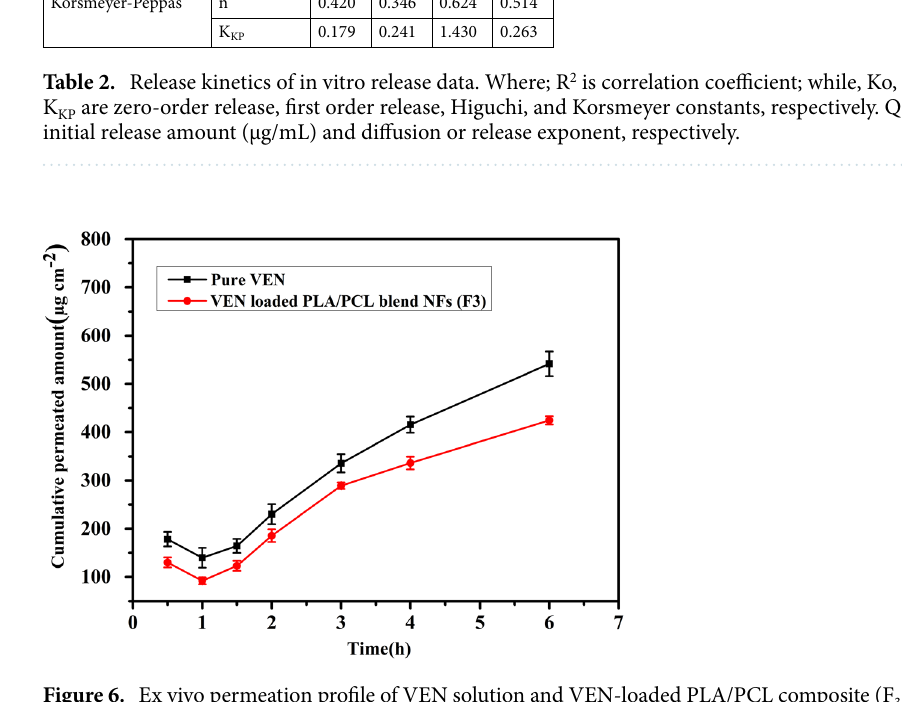
Figure 6. Ex vivo permeation profile of VEN solution and VEN-loaded PLA/PCL composite (F 3 ) across chicken cyst mucosa into phosphate buffer (pH 7.4) at 37 °C, data stated as average ± SD (n =